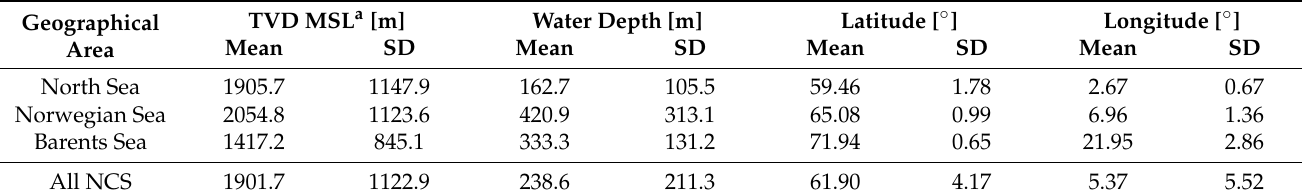
Figure 2. Histograms of leak-off pressures for the three geographical areas. Table 2. Statistics of geospatial information for leak-off pressures in the analyses.